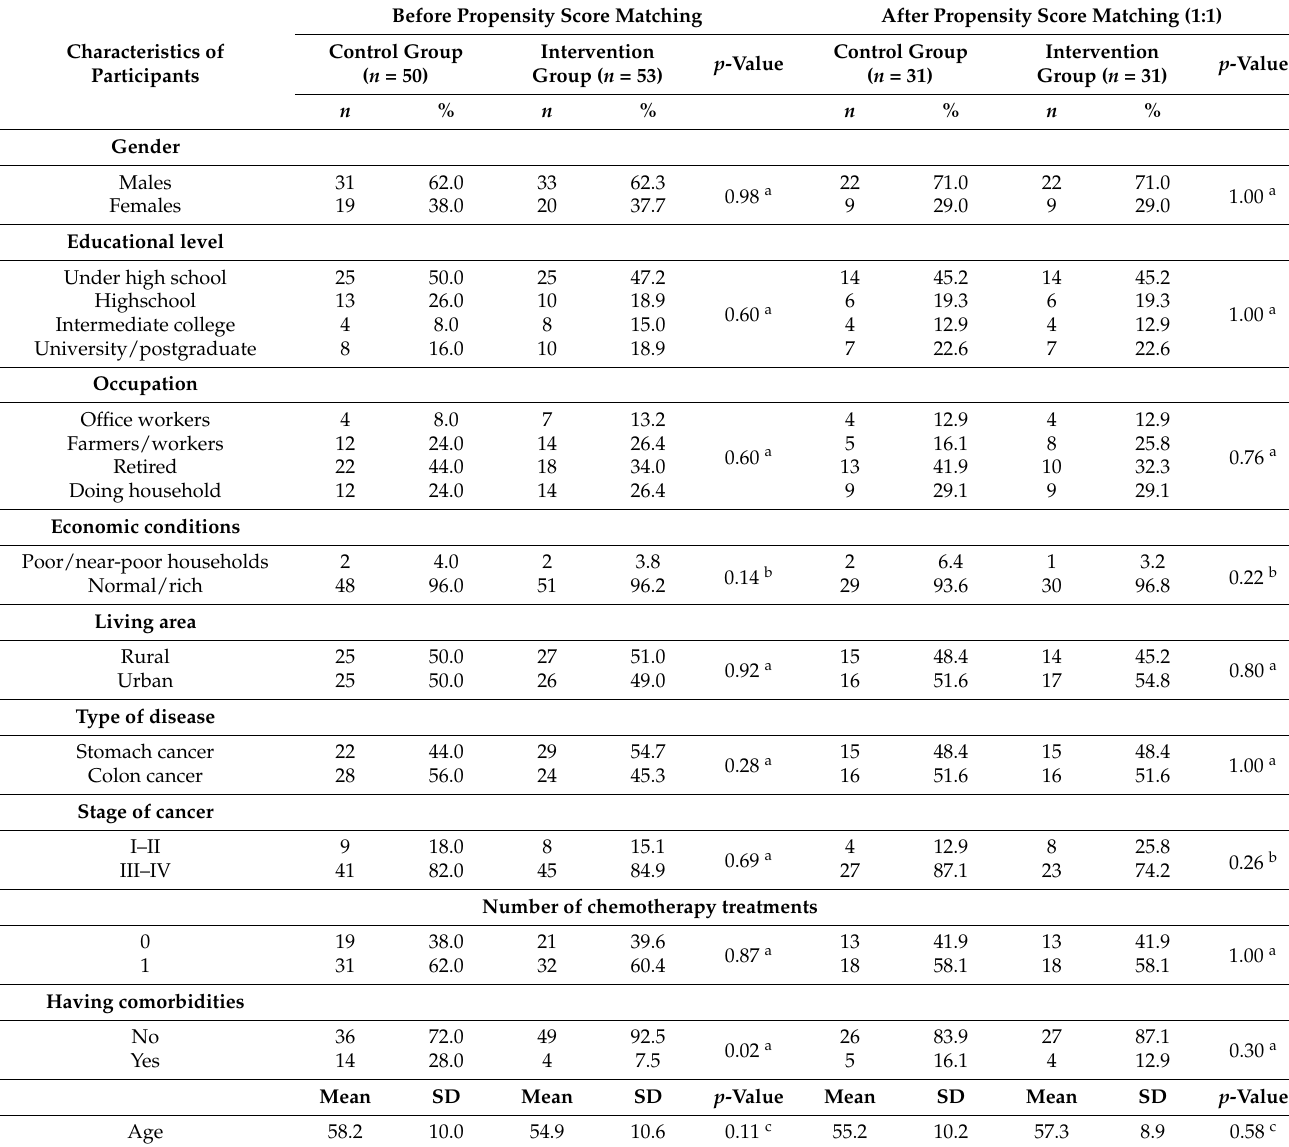
Table 1. Characteristics of participants before and after propensity score